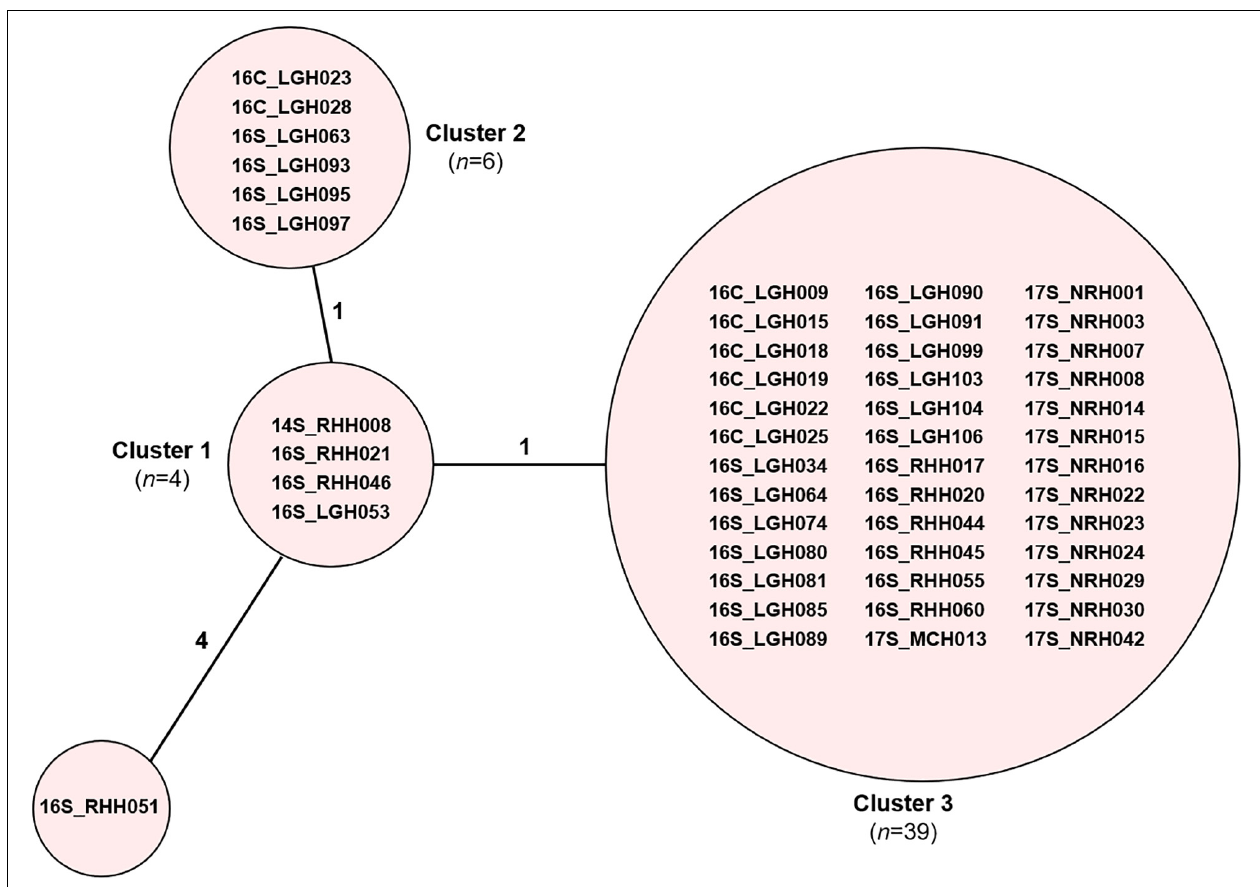
FIGURE 3 | cgMLST of ST1421 vancomycin-resistant Enterococcus faecium (VREfm) isolates ( n = 50). VREfm isolates belonging to sequence type ST1421 were analyzed by cgMLST in Ridom SeqSphere+ and are visualized in a minimum spanning tree. The isolates further differentiated into three clusters and one unique isolate (grouped into circles). The number of different alleles between clusters and the unique isolate is shown on the connecting lines (not to